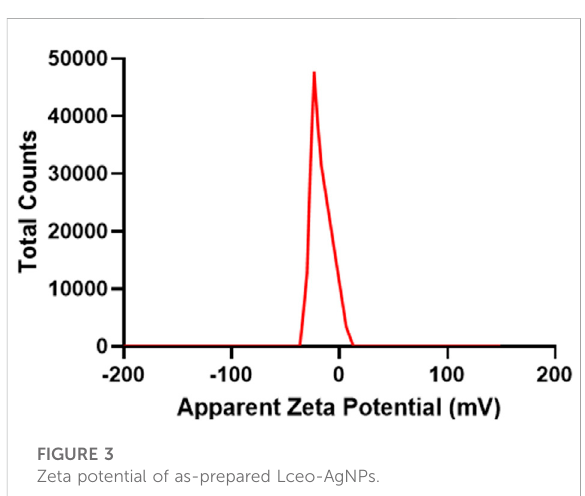
FIGURE 3 Zeta potential of as-prepared Lceo-AgNPs.